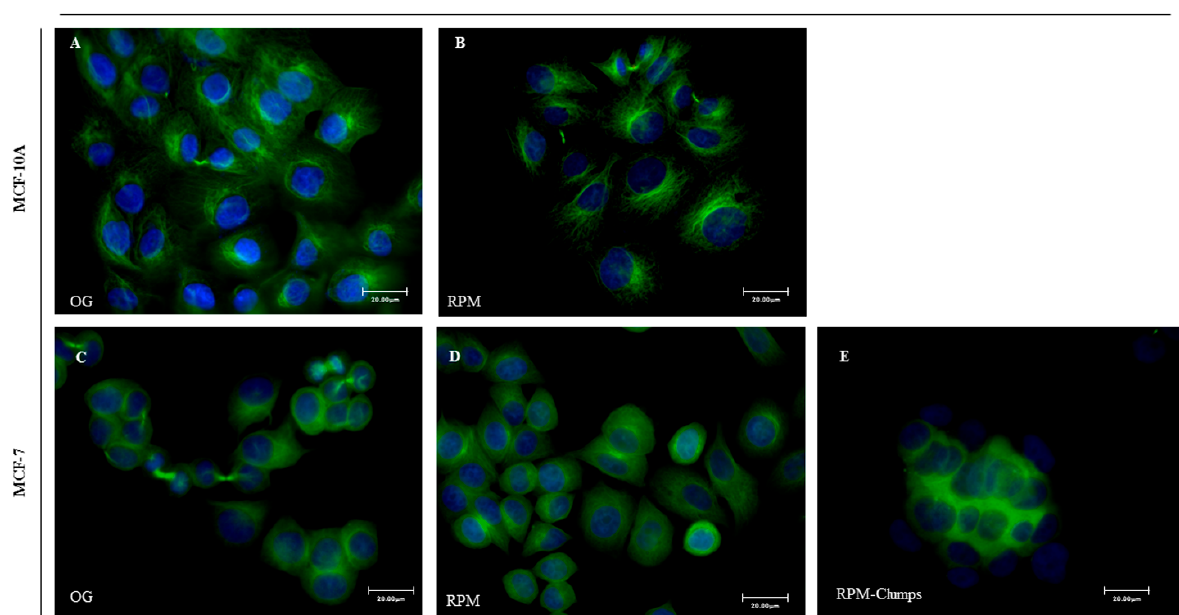
Figure 5. Immunofluorescence microscopy images of alpha-tubulin (in green) distribution pattern in MCF-10A ( A , B ) and MCF-7 ( C – E ) cultured in normal gravitational (OG) and microgravity (RPM) conditions for 24 h. Nuclei (in blue) were stained with TO-PRO-3 iodide. Scale bar 20 µm.